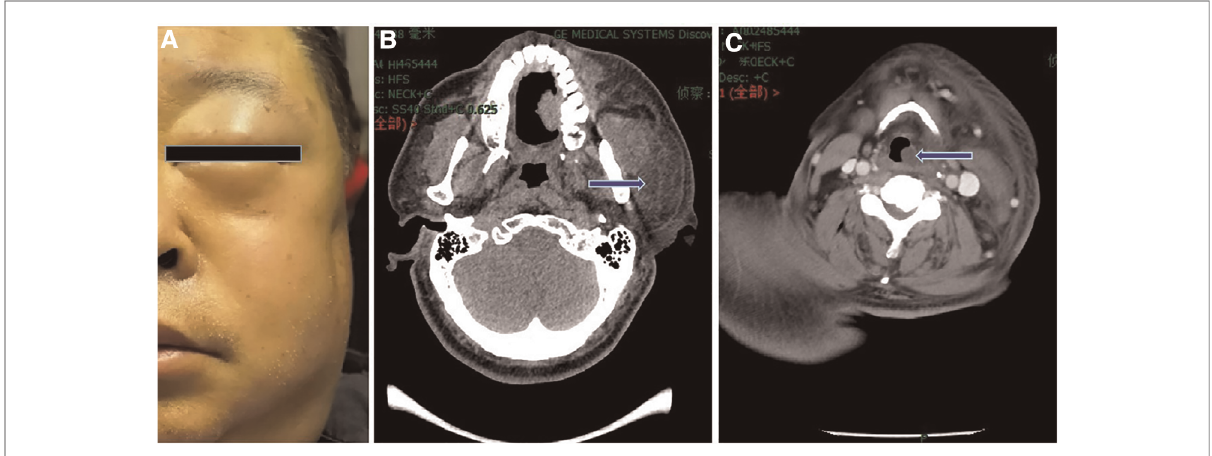
FIGURE 1 Clinical appearance and imaging fi ndings of the patient. ( A ) Photograph of the patient showing swelling of the left eyelid and parotid gland area. ( B ) Enhanced CT image showing signi fi cant enlargement of the left submandibular soft tissue and parotid gland (arrow). ( C ) Enhanced CT image showing the involvement of the left parapharyngeal space and airway stenosis